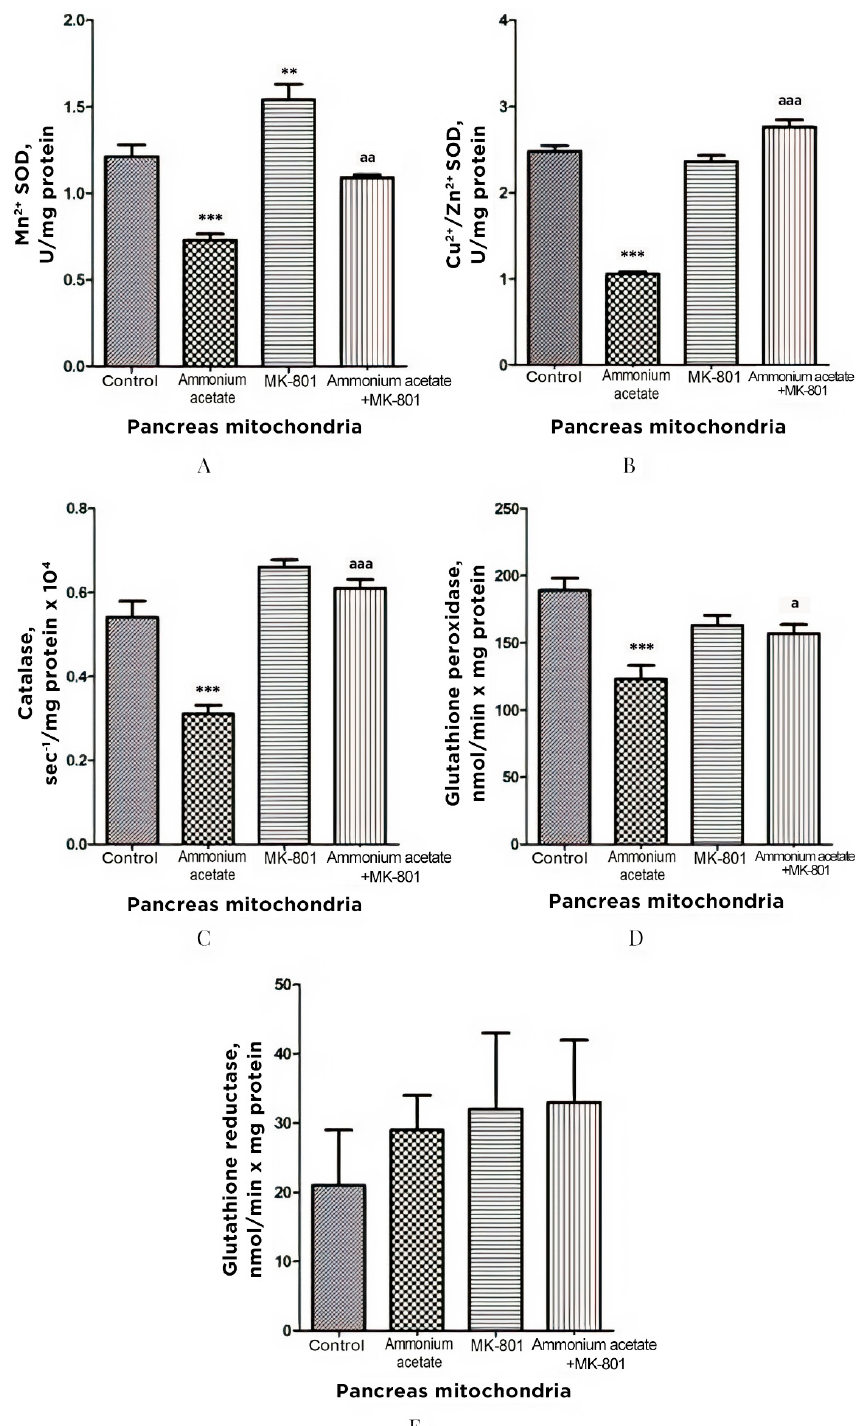
Figure 6. Effects of injection of ammonia and/or MK-801 on the activity of antioxidant enzymes superoxide dismutase (Mn 2+ ( A ) and Cu 2+ , Zn 2+ ( B ) isoforms), catalase ( C ), glutathione peroxidase ( D ), and glutathione reductase ( E ) in pancreatic mitochondria. Experimental design was the same as in Figure 1 legend. The enzyme activity was determined as indicated in Materials and Methods. The results are represented as mean ± SEM. Values significantly different from the control group are designated with two (**) and three (***) asterisks: ** p < 0.01, *** p < 0.001 (Student’s t -test). a significant differences, compared with ammonia group. a p < 0.05, aa p < 0.01, aaa p < 0.001 (with the Bonferroni correction for multiple